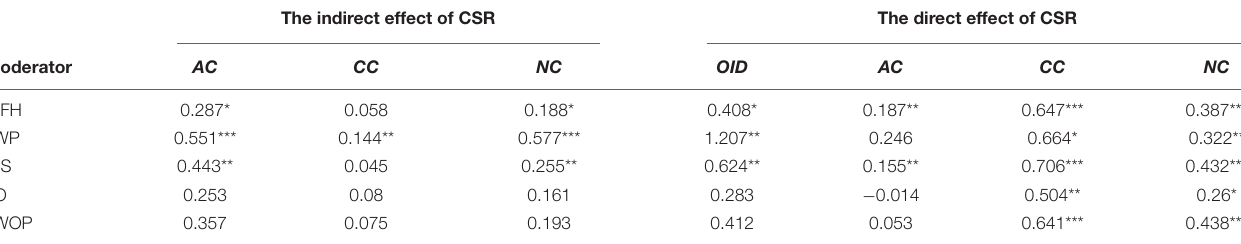
TABLE 5 | Moderation of HR practices.